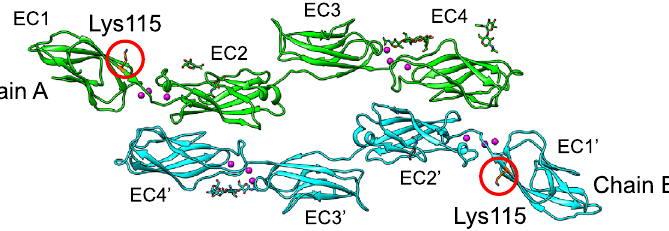
Figure 3. Position of Lys115 mapped on the crystal structure of LI-cadherin EC1-4 homodimer (PDB: 7CYM). Lys115 is shown in orange. Lys115 is located on the opposite side of the homodimer interface.